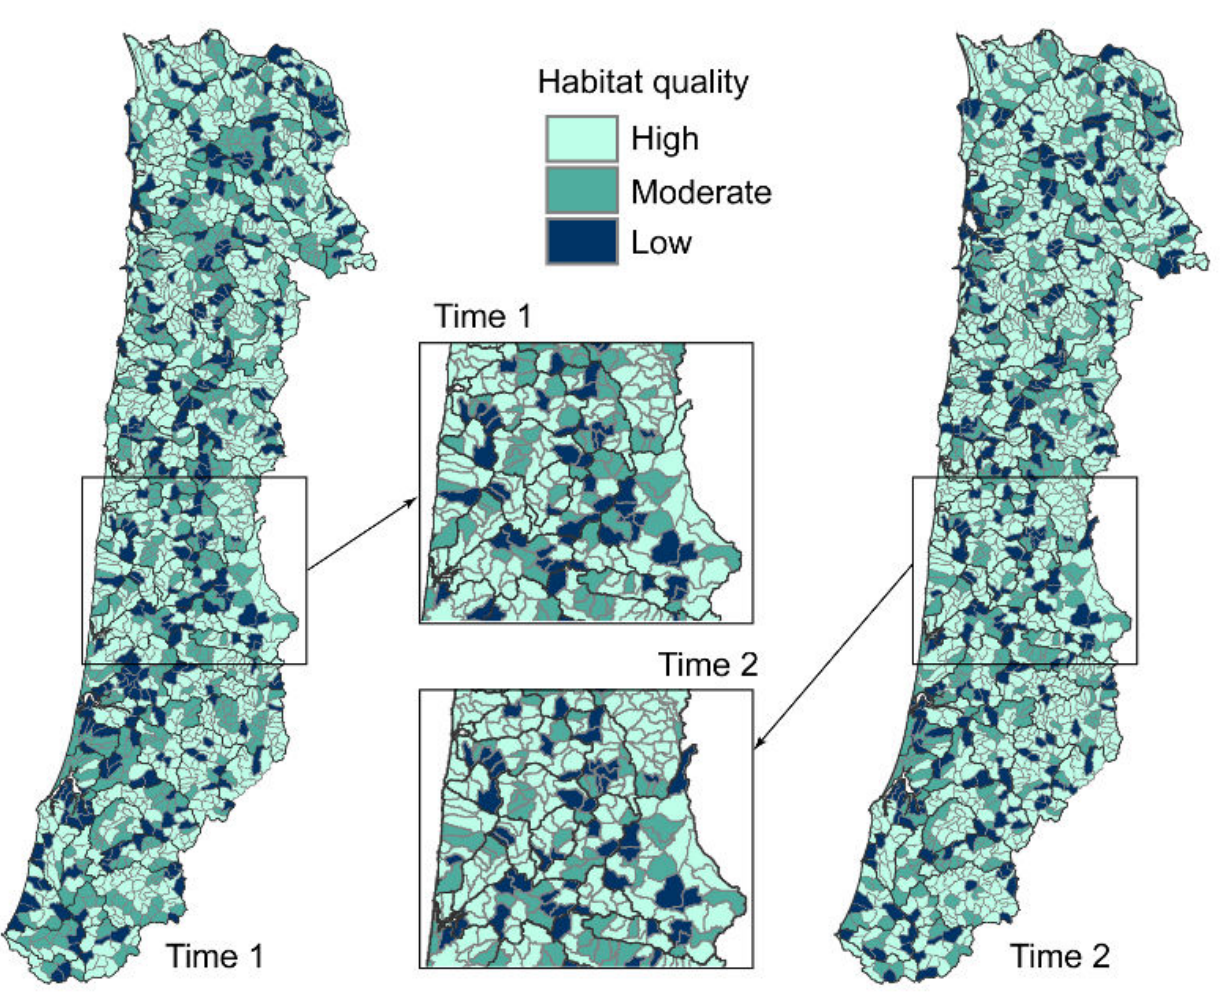
Fig. 3. A schematic of aggregate watershed condition (ecological state) at anytime time. The map on the left might be the current distribution of ecological condition in 7th-field watersheds and the map on the right might be the target condition. The target condition could be based on the historical distribution of ecological